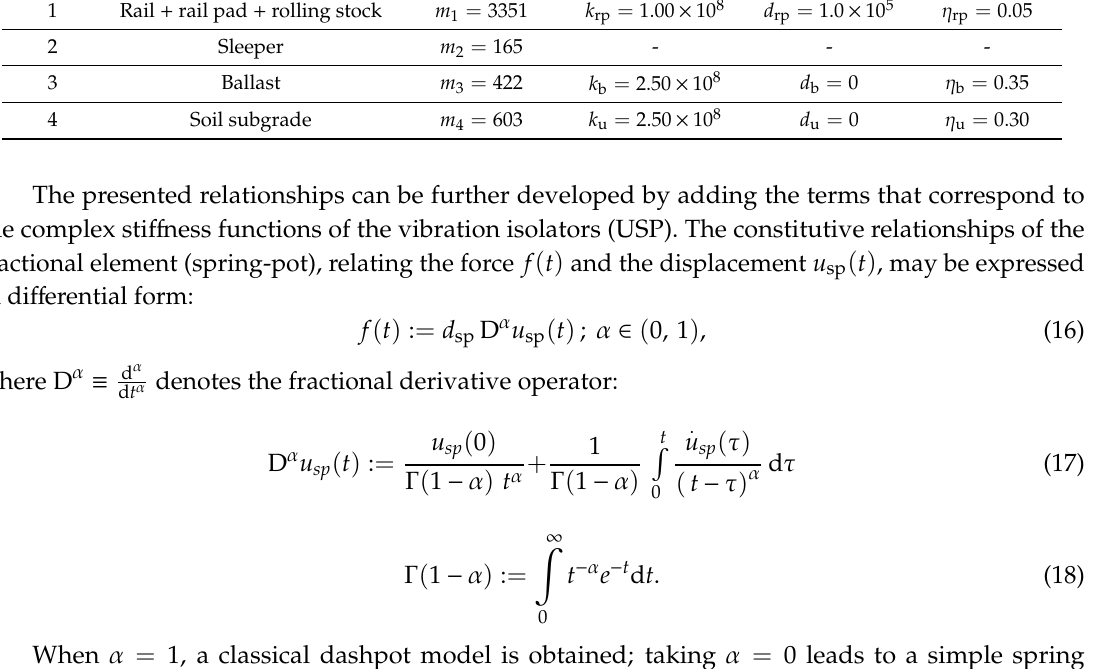
Figure 8. The curve fitting algorithm is based on the calculation of the dynamic sti ff ness moduli, which are the absolute values of the complex sti ff ness k